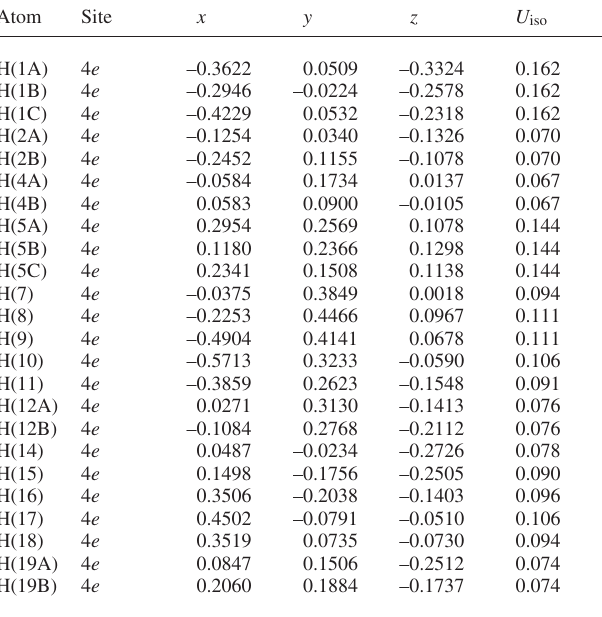
Table 2. Atomic coordinates and displacement parameters (in Å 2 )